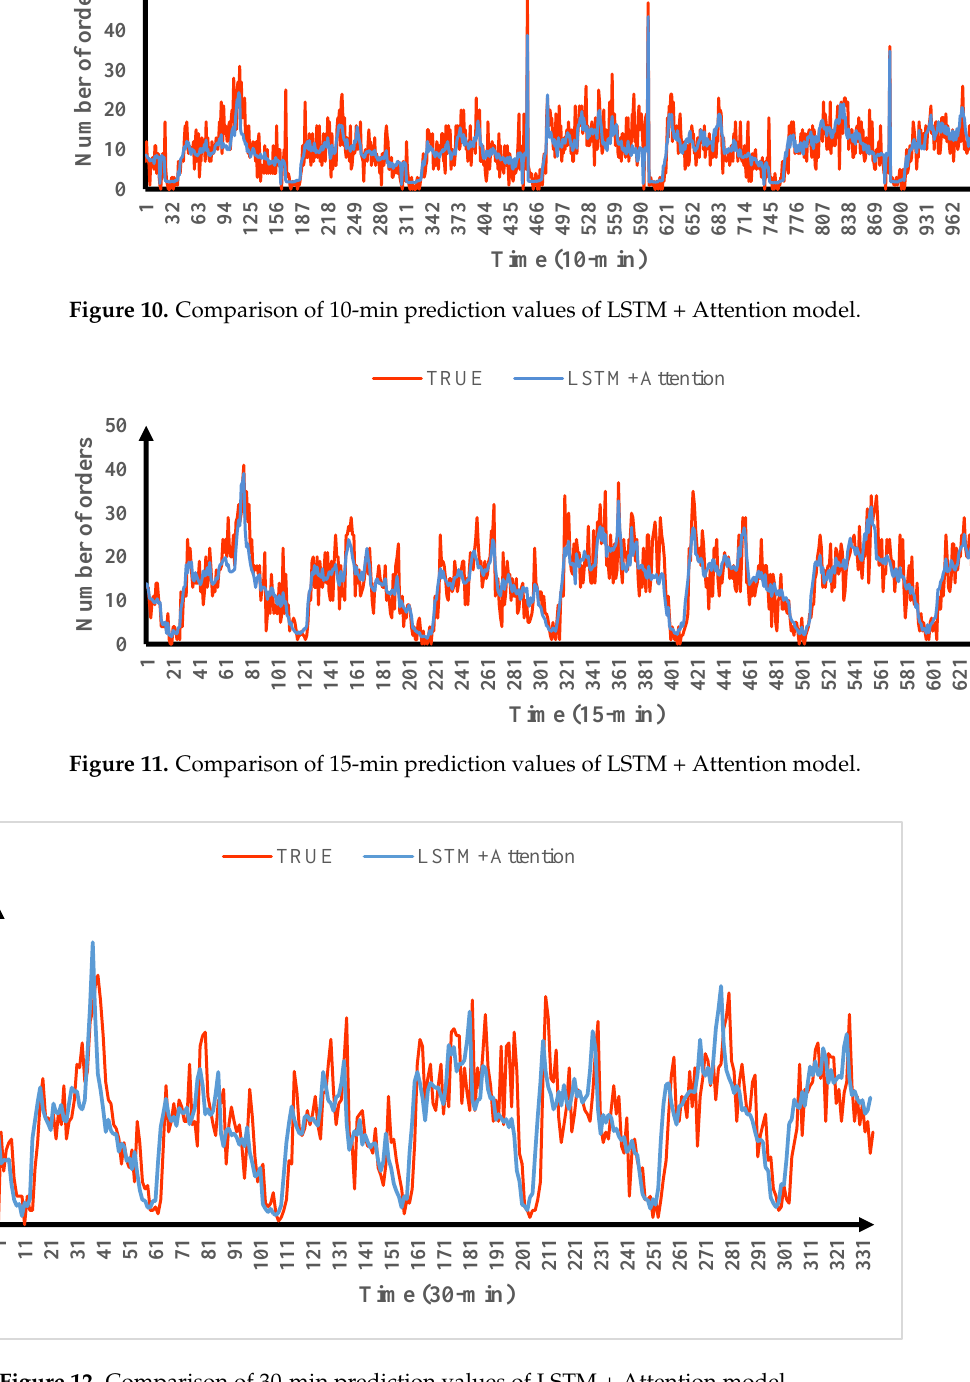
Figure 12. Comparison of 30-min prediction values of LSTM + Attention model.